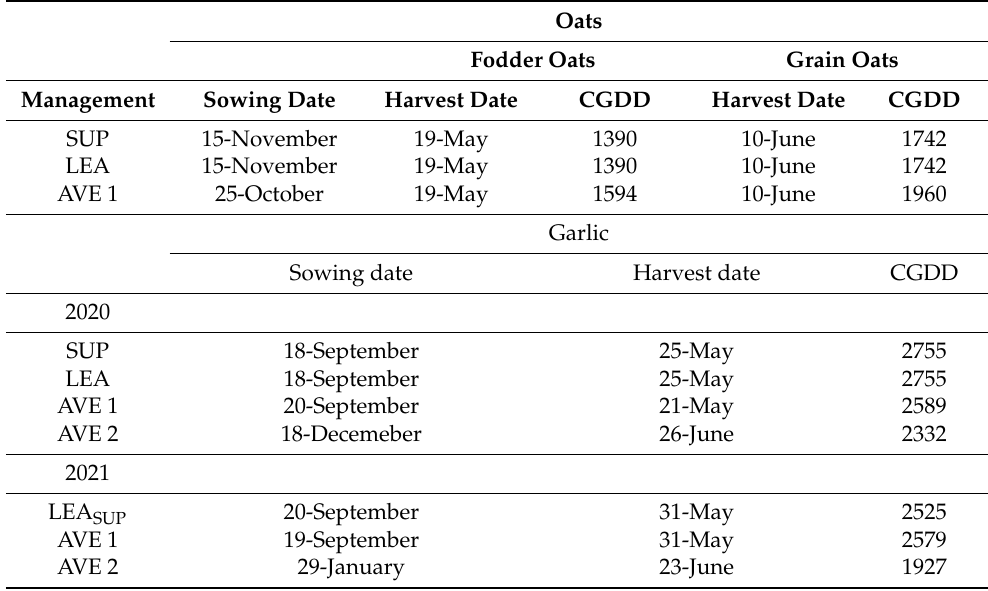
Table 5. Sowing and harvest dates and observed CGDD for fodder and grain oats and garlic crop. Oats Fodder Oats Grain